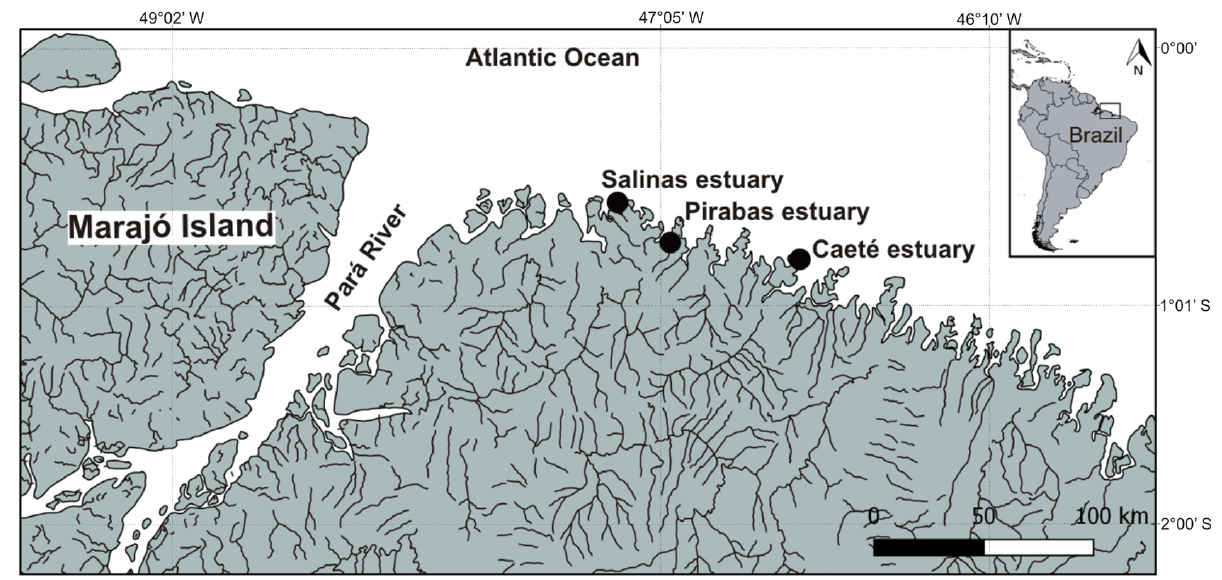
Figure 1. Estuaries sampled along the Pará coast, northern